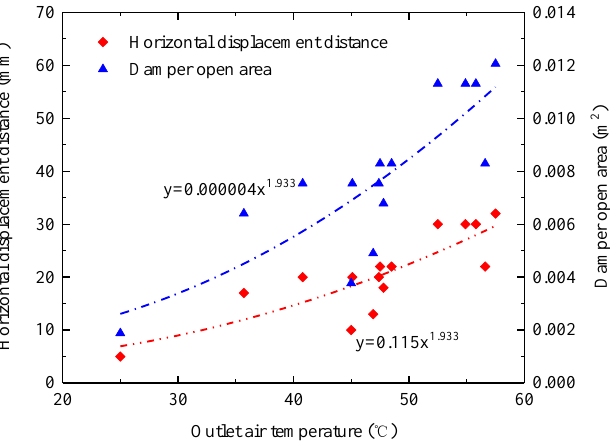
Figure 10. The relationship between the outlet temperature and damper displacement distance.